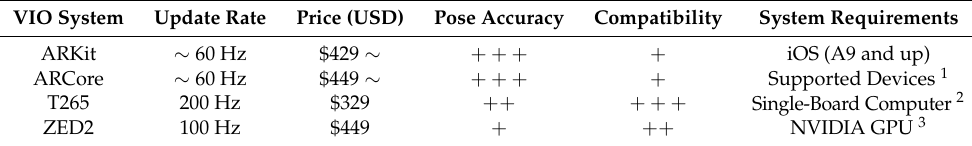
Table 3. Economic comparison of the four commercial VIO